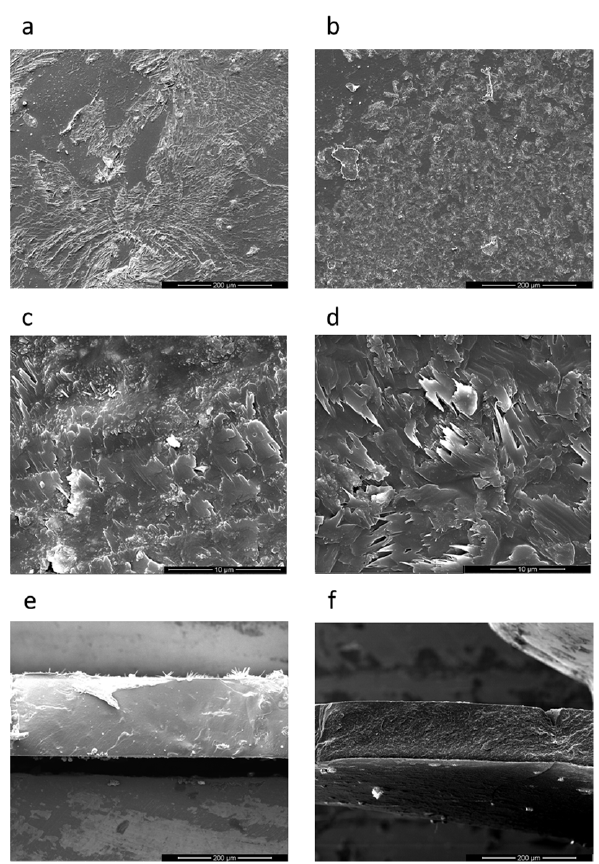
Figure 10. Scanning electron microscopy (SEM) images of the surface ( a – d ) and cross section ( e , f ) of the membrane: pristine membrane ( left ) and membrane after the chronoamperometry experiment ( right ).